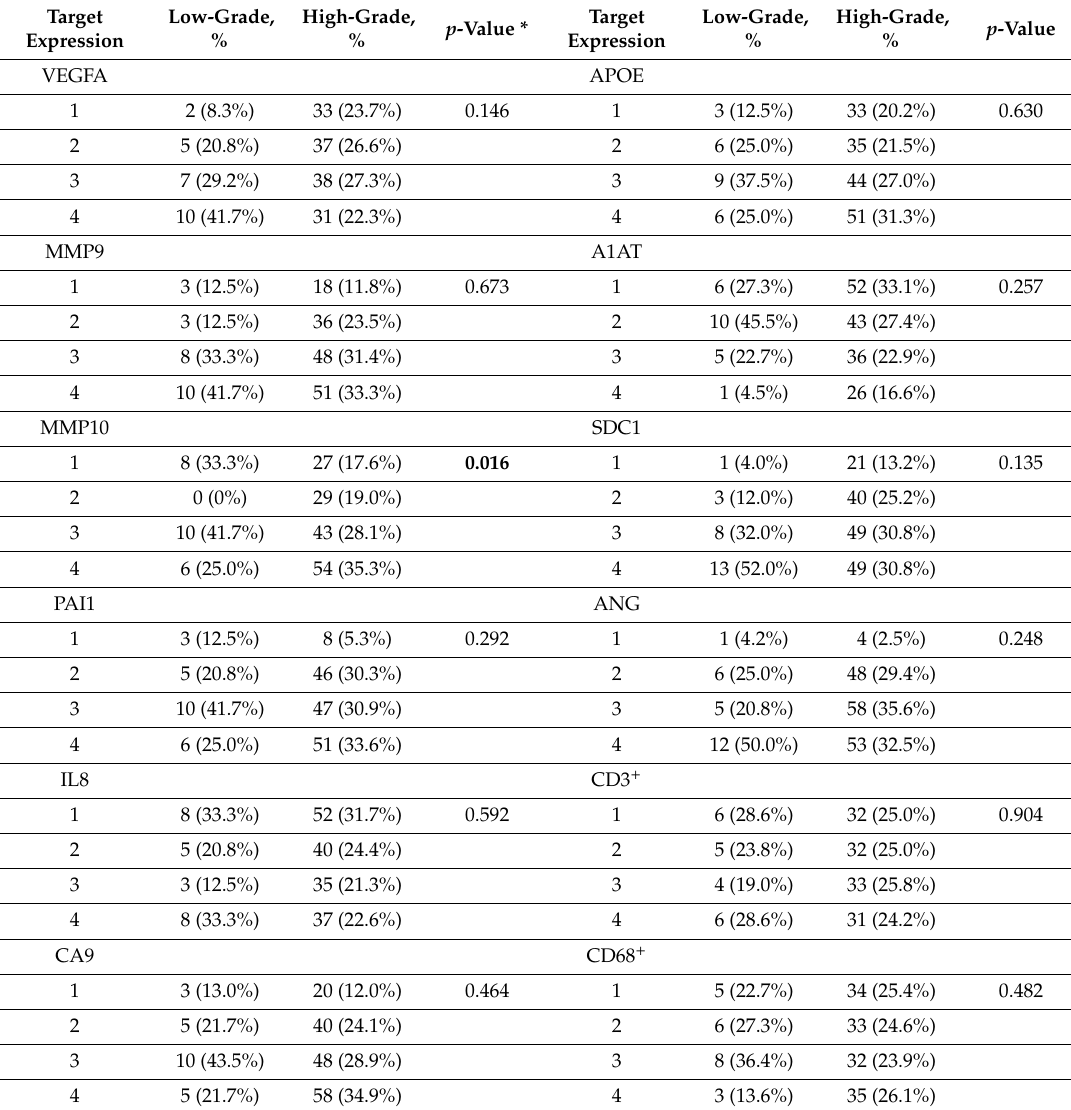
Table 3. Relationship between immunochemical features and tumor grade.